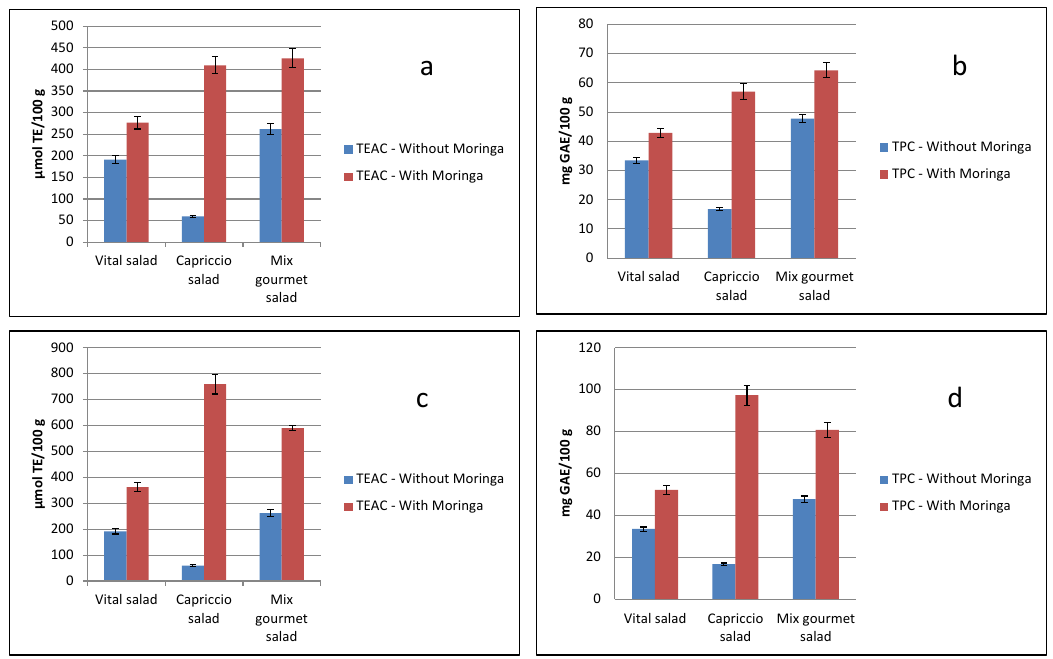
Figure 3. Increase in Trolox equivalent antioxidant capacity (TEAC) and total polyphenol content (TPC) in salad by adding MO ( a , b ) or by replacing an ingredient with MO ( c , d ).